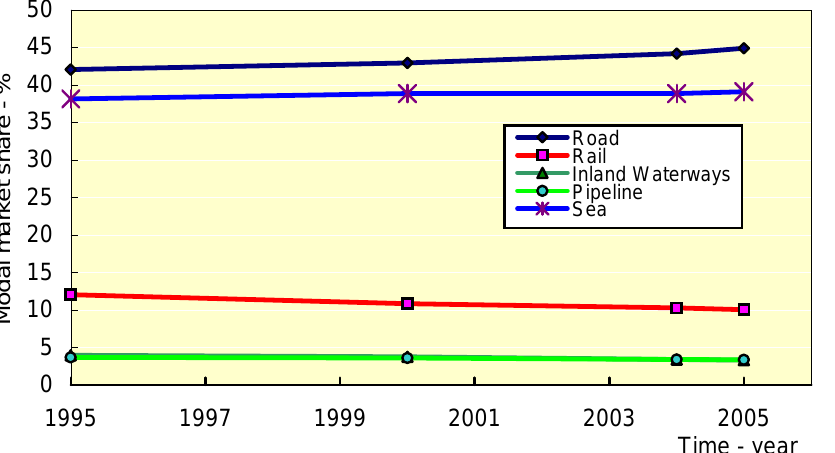
Figure 2. An example of modal split between different freight transport modes in European Union (EU-25) (t-km ton-kilometres) (Compiled from EC,